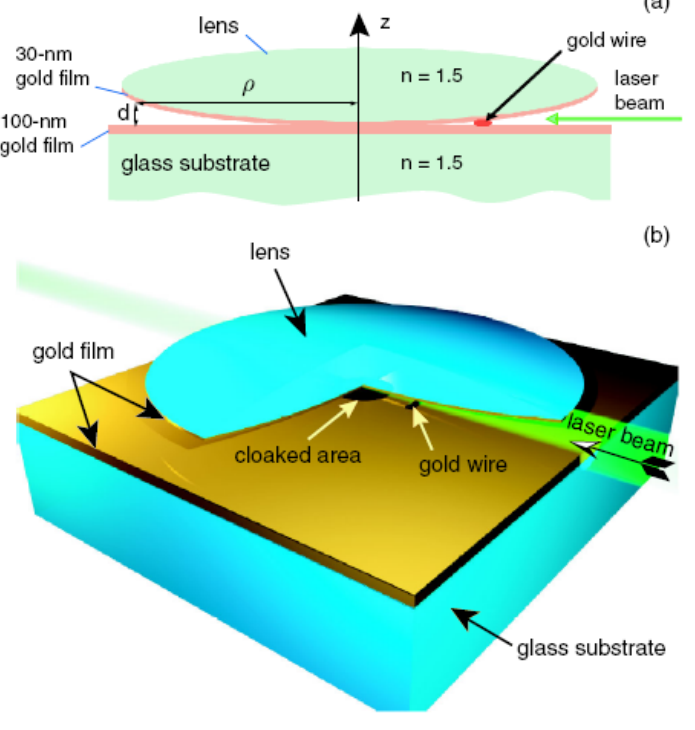
Figure 2. Tapered waveguide acting as an optical cloak (not to scale). ( a ) Cross-section sketch for the waveguide experiment. ( b ) 3D rendition of the experimental setup sketched in (a); in the figure one-quarter of the gold-coated lens is removed to show the interior